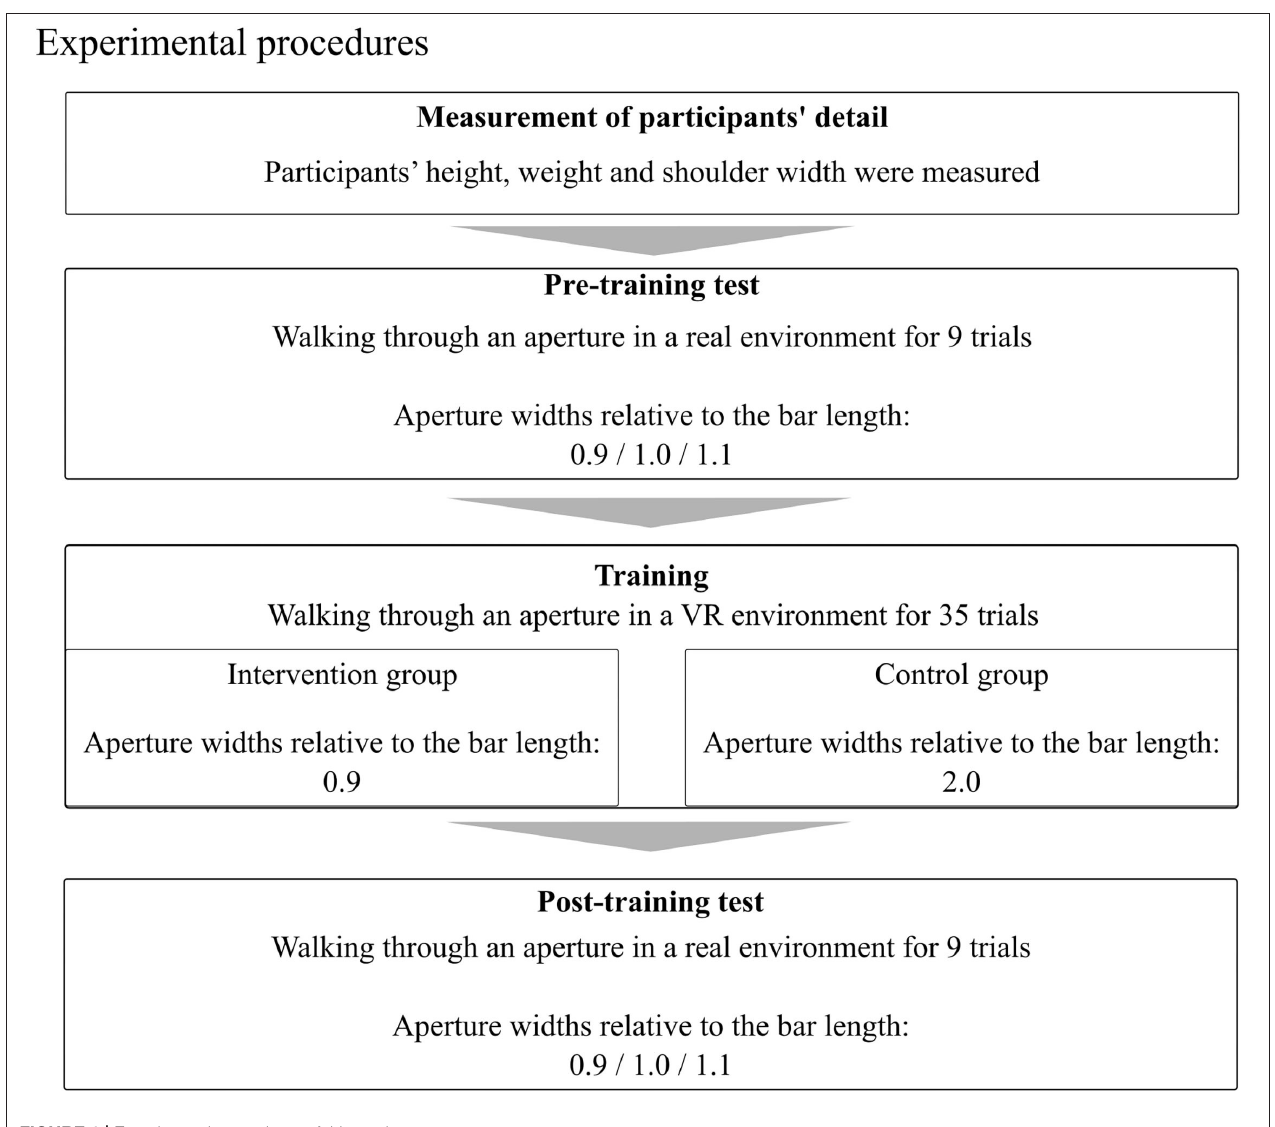
FIGURE 1 | Experimental procedures of this